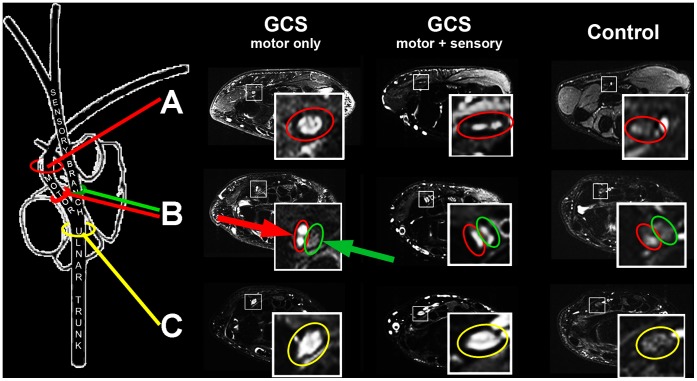
Representative findings of nerve T2-signal increase on single subject level.one GCS patient with isolated motor symptoms (left column), another with combined motor and sensory symptoms (middle column), both compared to one asymptomatic control (right column). Three image sections from distal (A) to proximal (C) are given and image positions indicated on the anatomical schematic drawing on the left (with permission from The Journal of Bone and Joint Surgery, Volume 51, pages 1095–1103). The deep motor branch at the level of the hook of the hamate is encircled in red and found in the upper image row (A = slice position 10). Just distal to the bifurcation of the ulnar nerve motor and sensory branches are encircled in red and green, respectively (middle image row, B, slice position +3). Just proximal to the bifurction the ulnar nerve trunk is encircled in yellow (lower image row, B = slice position -3). In GCS with isolated motor symptoms (left column, GCS motor only) increased nerve T2-signal was most noticeable within the deep motor branch (red arrow) and extended over a short distance proximally into the ulnar nerve trunk (yellow circle in C), while the T2-signal was normal within the superficial sensory branch (green arrow). In case of combined motor and sensory symptoms both distal ulnar nerve branches clearly show an incresed nerve branch T2-signal (red and green circle without arrows in level B, middle column, GCS motor+sensory).